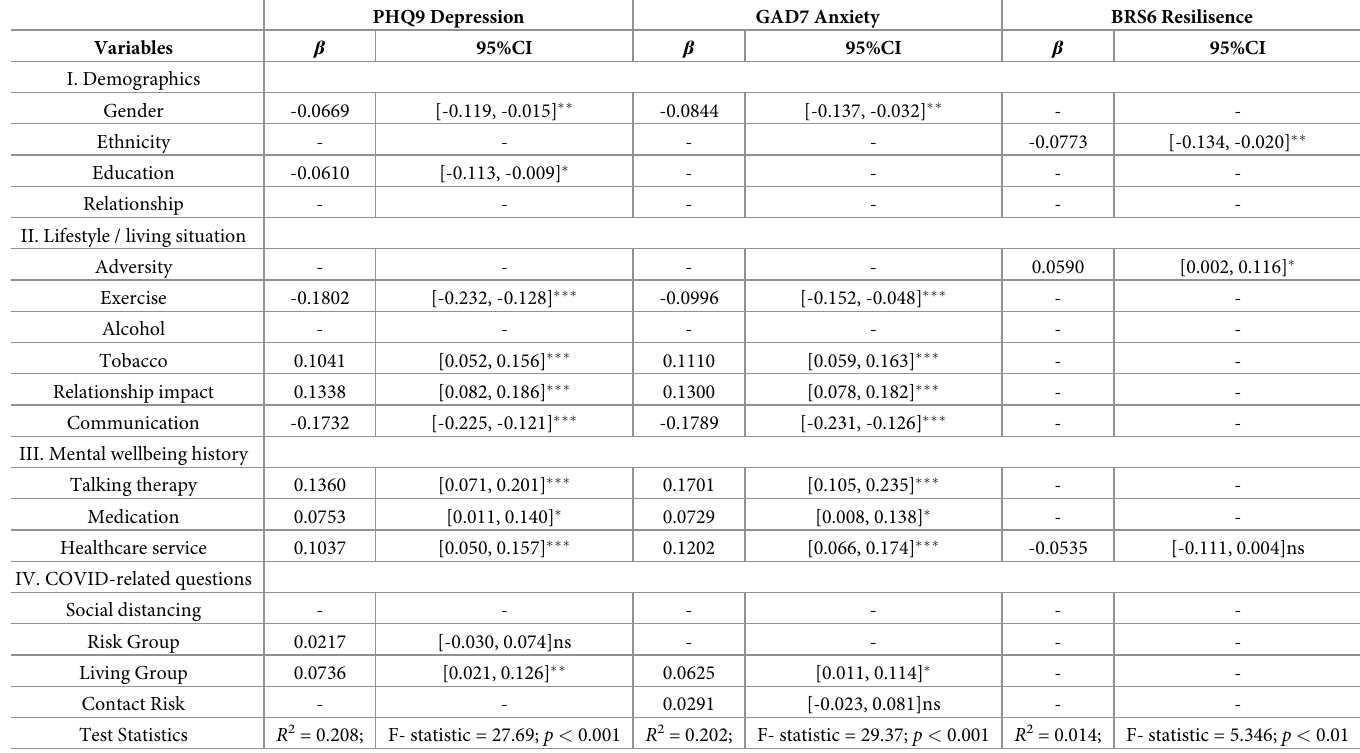
Table 13. Regression analysis, where ns = non- significant( p > 0.05), � ( p � 0.05); �� ( p � 0.01); ��� ( p �